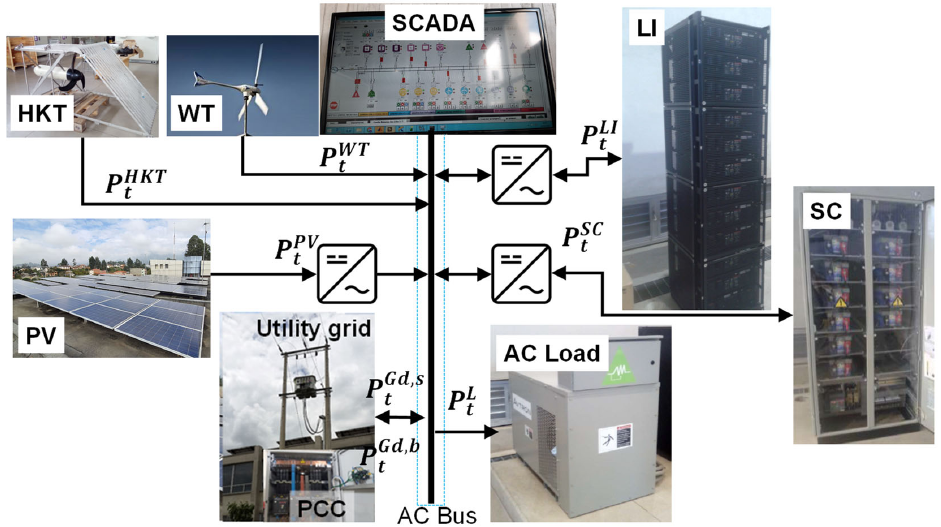
Figure 5. Connection diagram of the laboratory equipment used in this experiment. Table 1. Technical characteristics of the microgrid laboratory equipment at the University of Cuenca